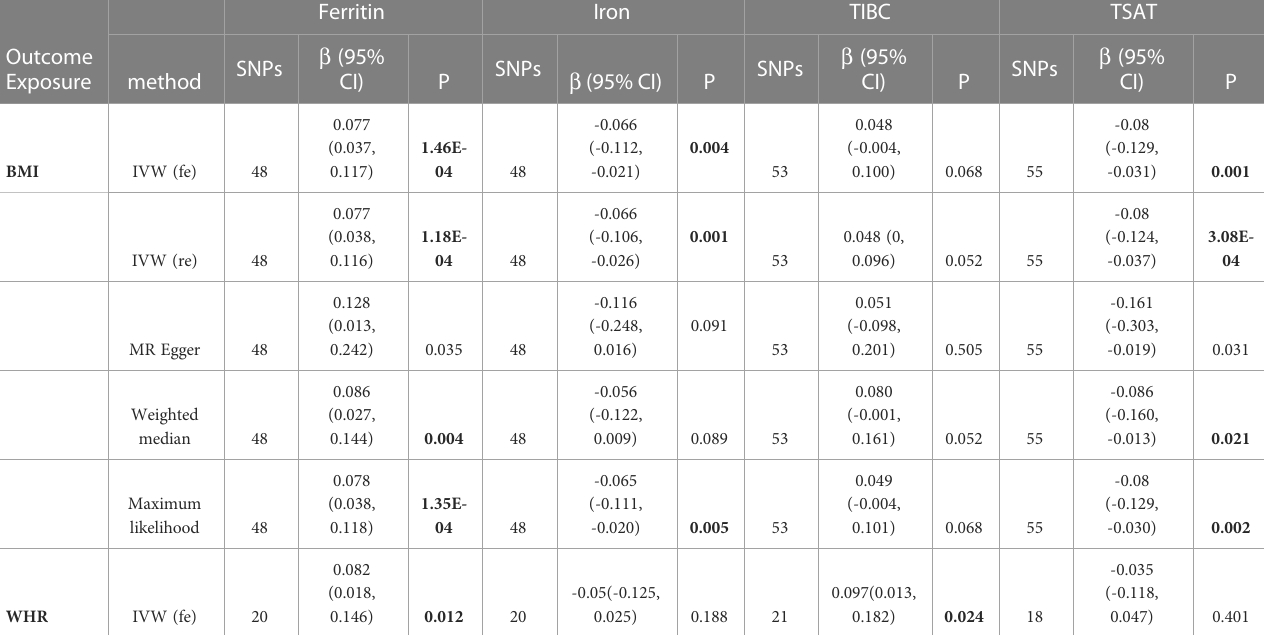
TABLE 2 MR results of the causal estimates of genetically predicted obesity-related traits on iron status.